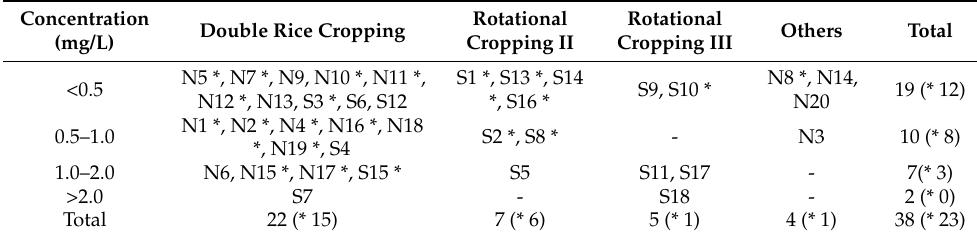
Table 6. Dissolved oxygen (DO) in different concentration ranges of all monitoring wells under various cropping patterns.